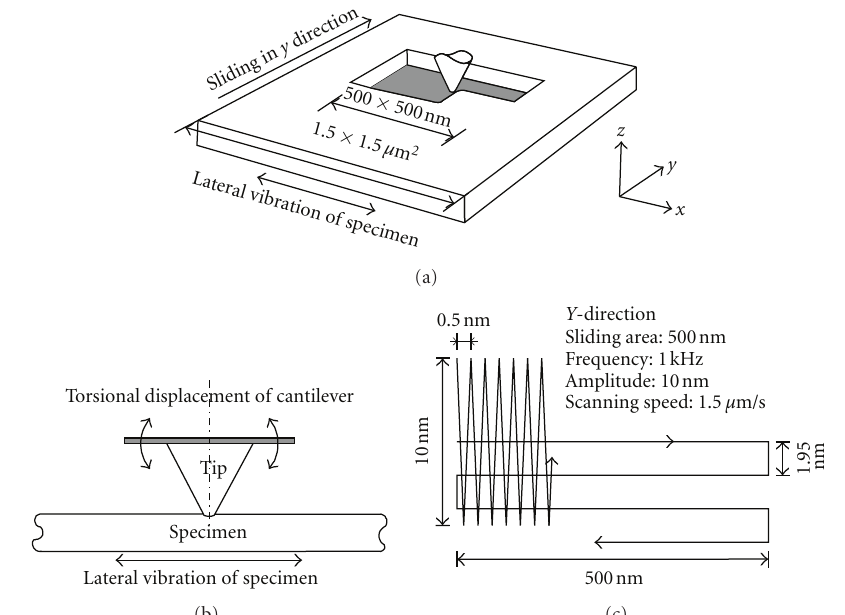
Figure 3: A model of the processing method by LM-FFM system (a), the torsional displacement of tip (b), and schematic of AFM tip trajectory during processing (c).